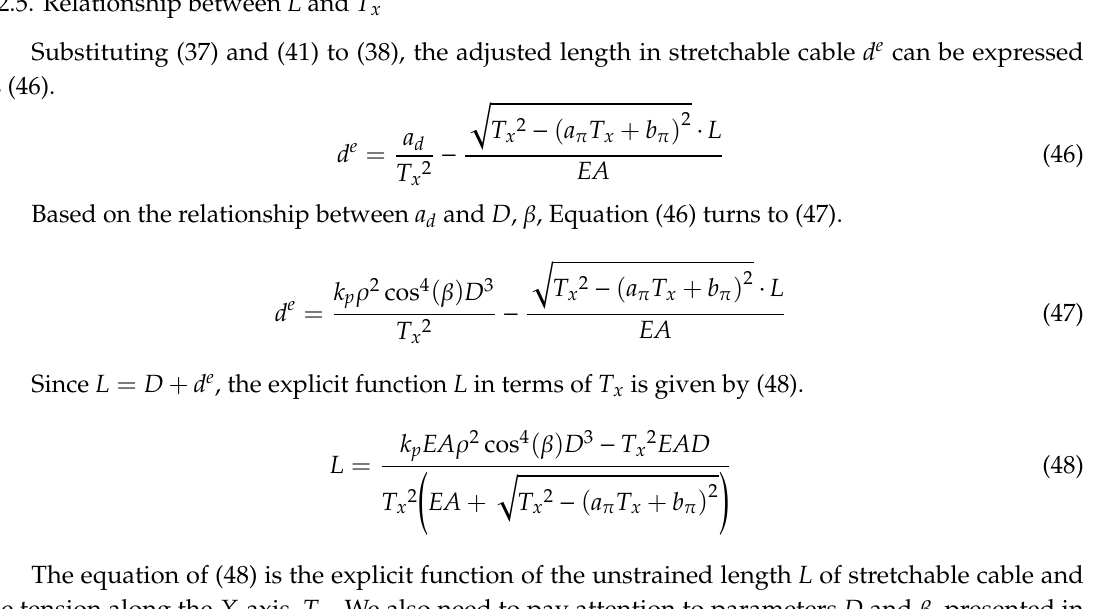
Figure 14. The relationship between